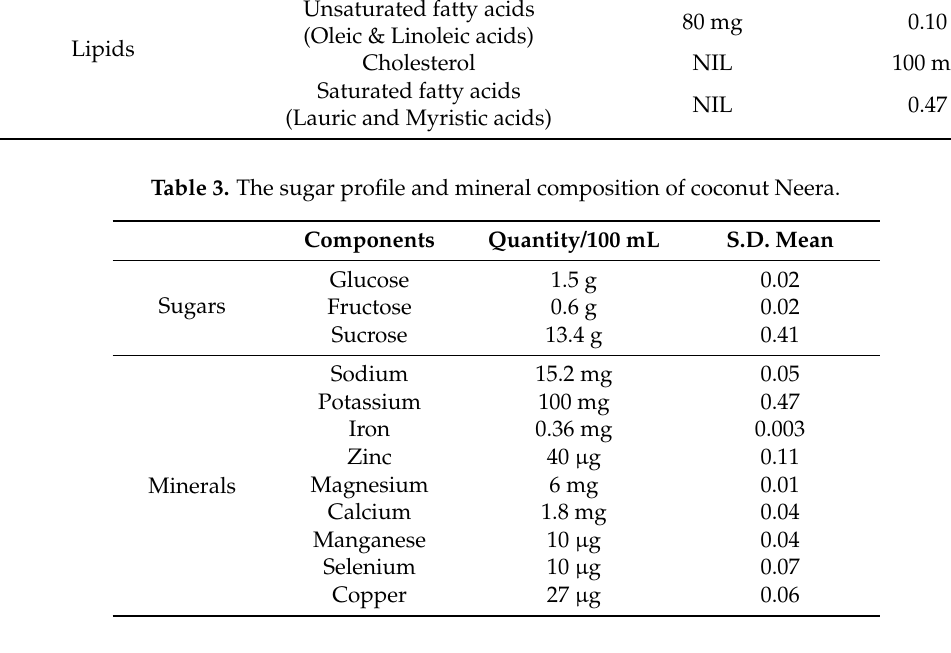
Table 4. The amino acid profile and vitamin content of coconut